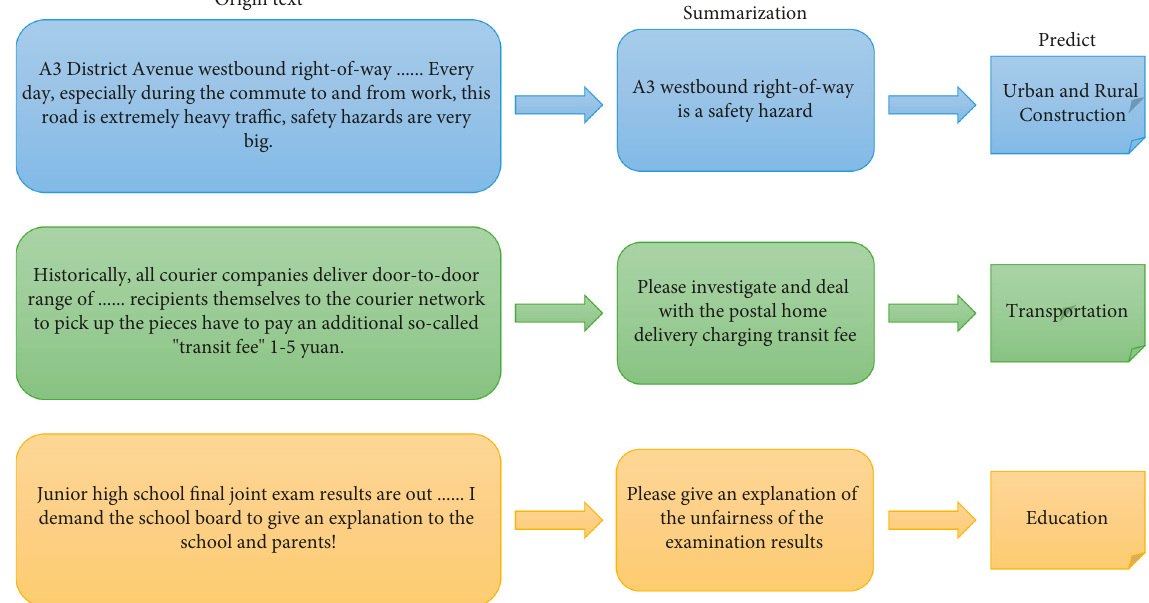
Figure 8: Visualization of results. The left column is the original text content, the middle column is the summarization of the original text, and the right column is the category predicted by our